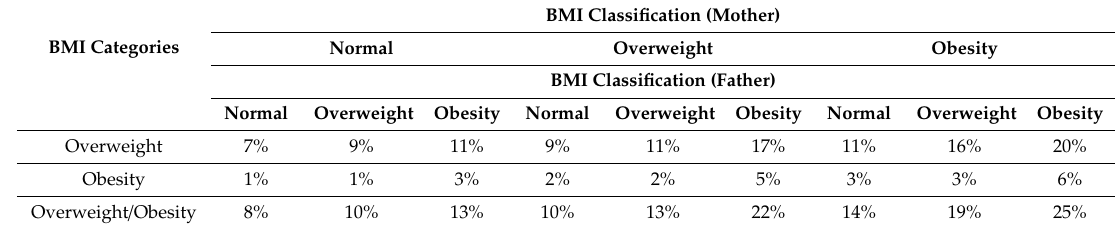
Table 6. Prevalence of overweight and obesity in children depending on the BMI classification of both parents.